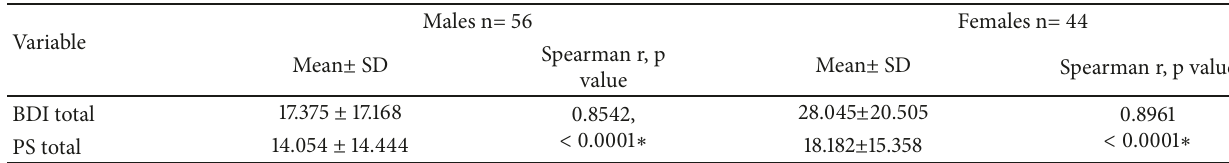
Table 7: Association of depression with stigma in both